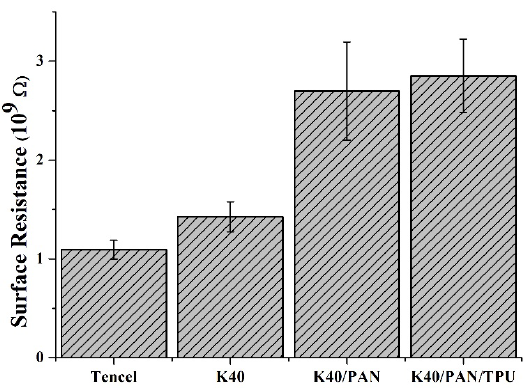
Figure 6. Surface resistance of Tencel, K40, and K40/PAN/TPU lay-up compound